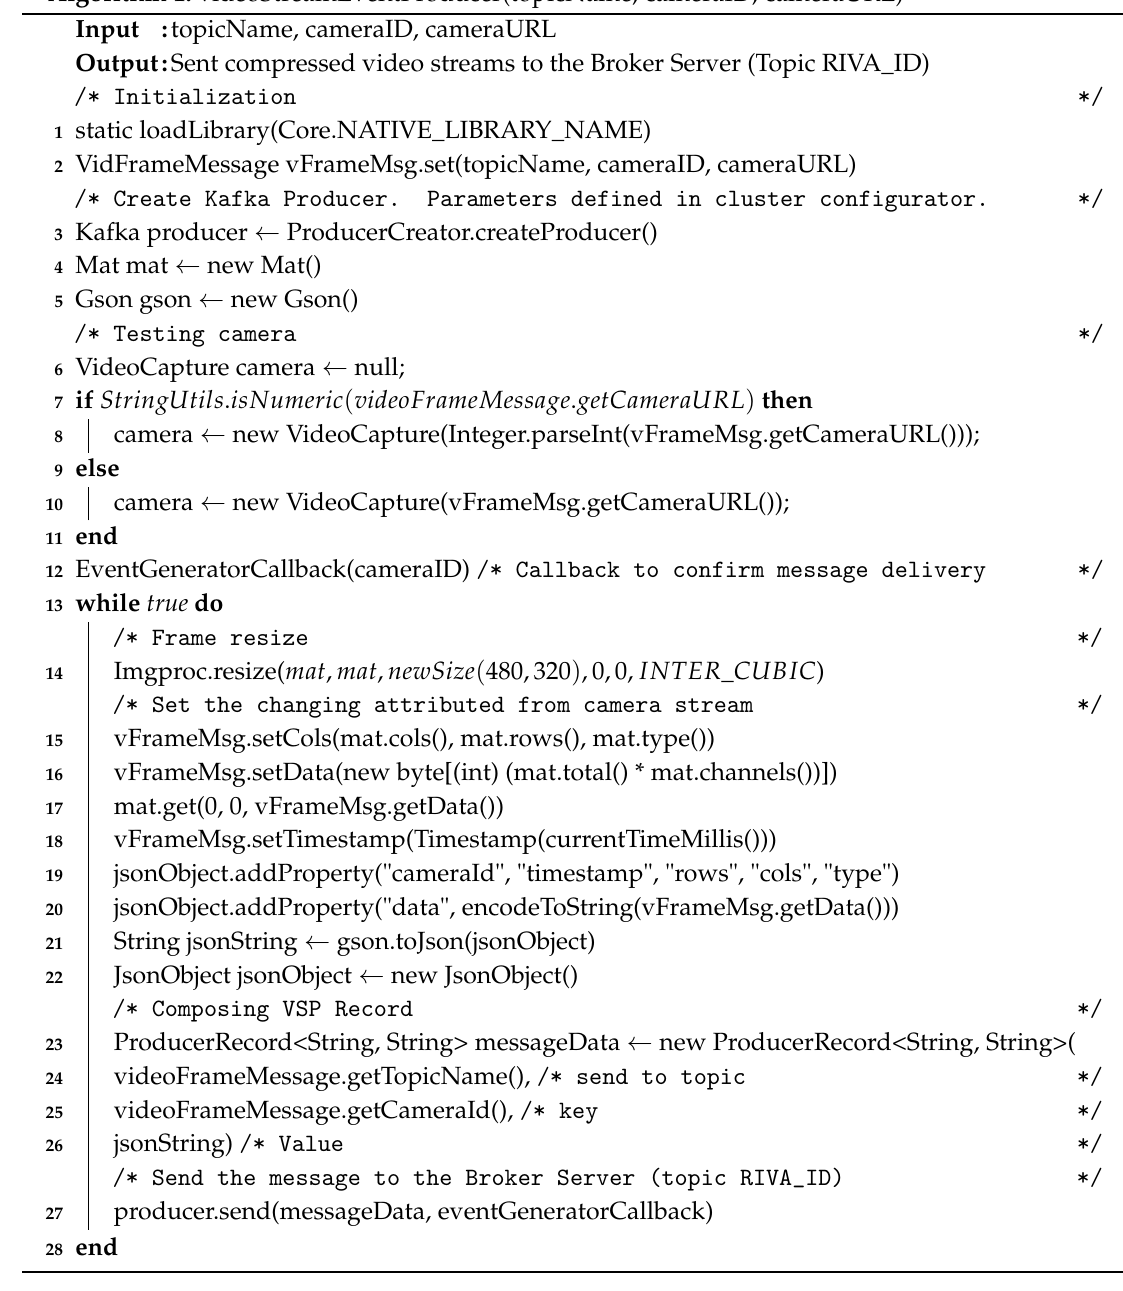
Algorithm 1: videoStreamEventProducer(topicName, cameraID,